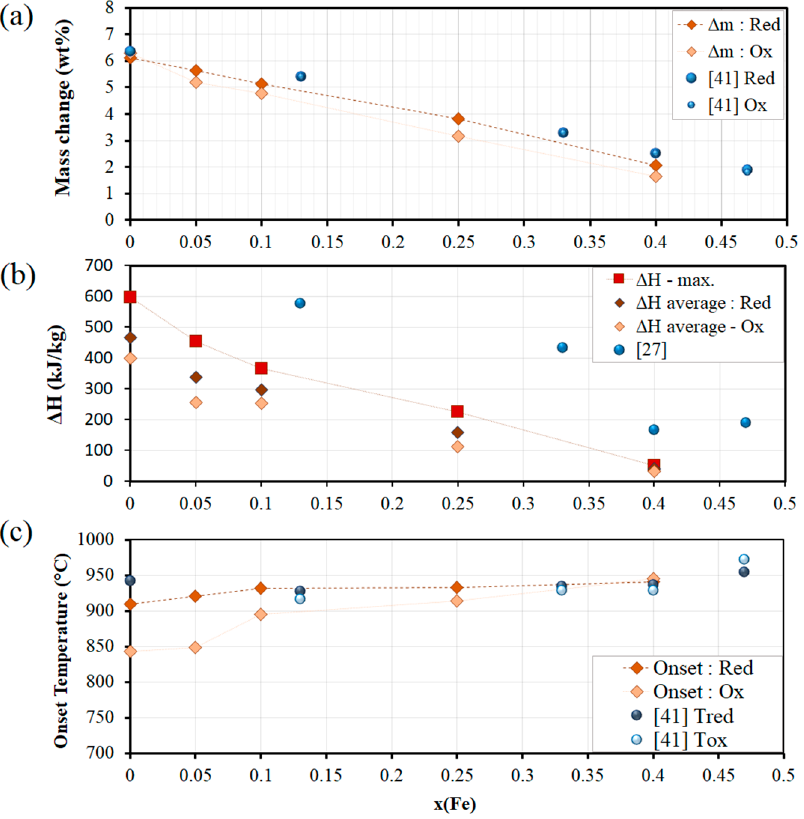
Figure 1. Mass variation (OSC), enthalpy change and onset temperatures of redox reactions measured for the Co-Fe-O system.